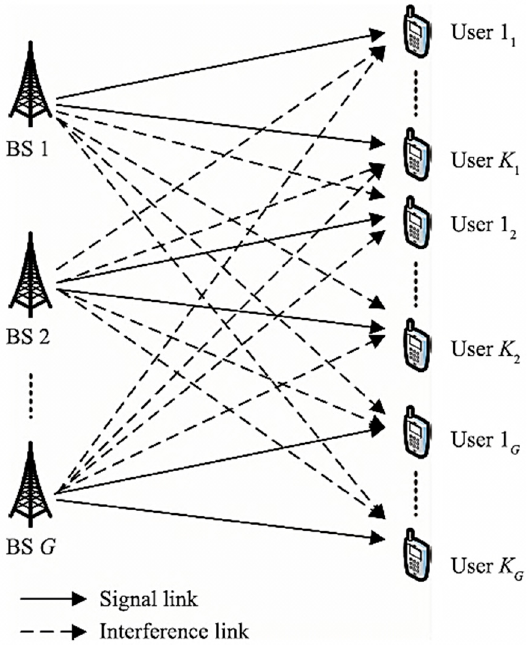
Figure 1. The proposed system model for massive MIMO-BC with G-cells.